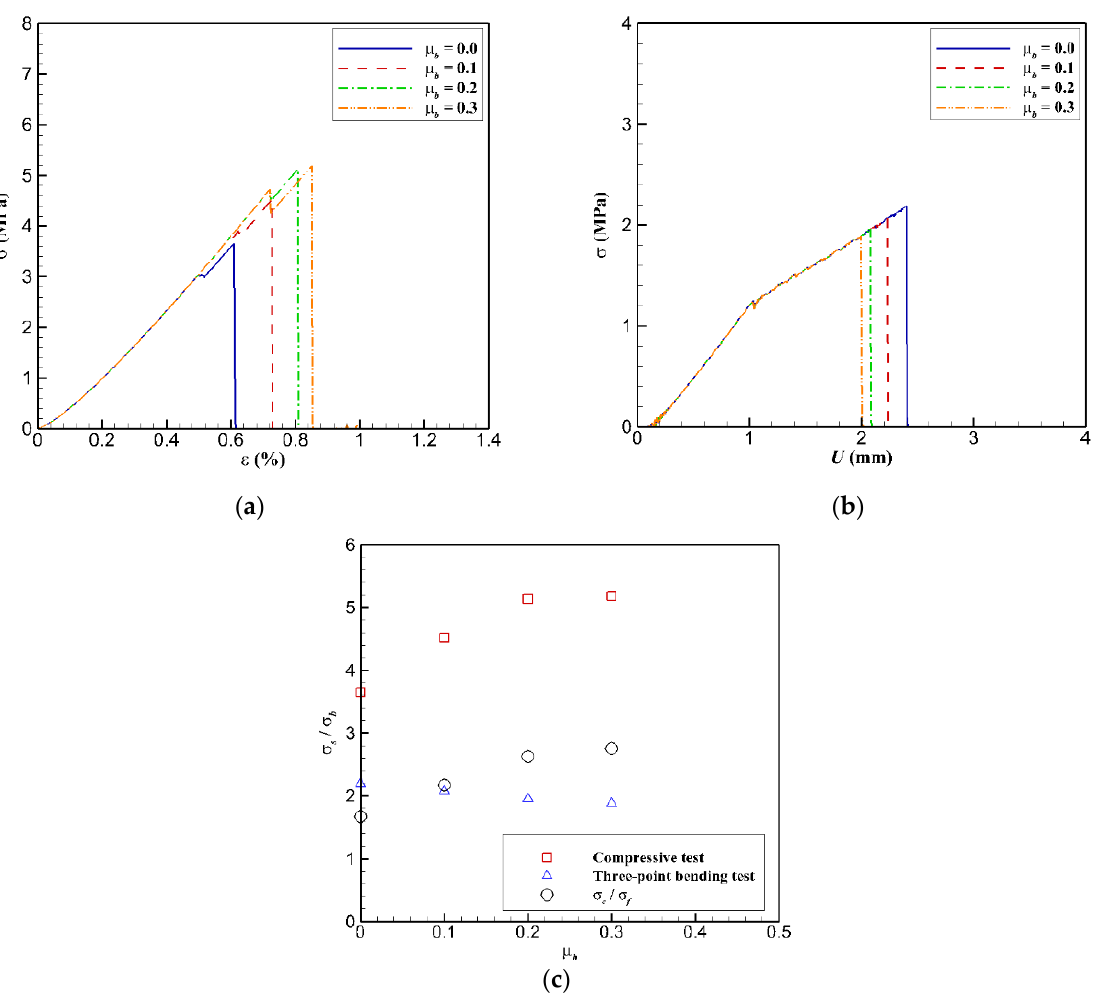
Figure 12. Effect of bond friction coefficient: ( a ) stress–strain curve; ( b ) stress–deflection curve; ( c ) ratio of simulated strength to bond strength.